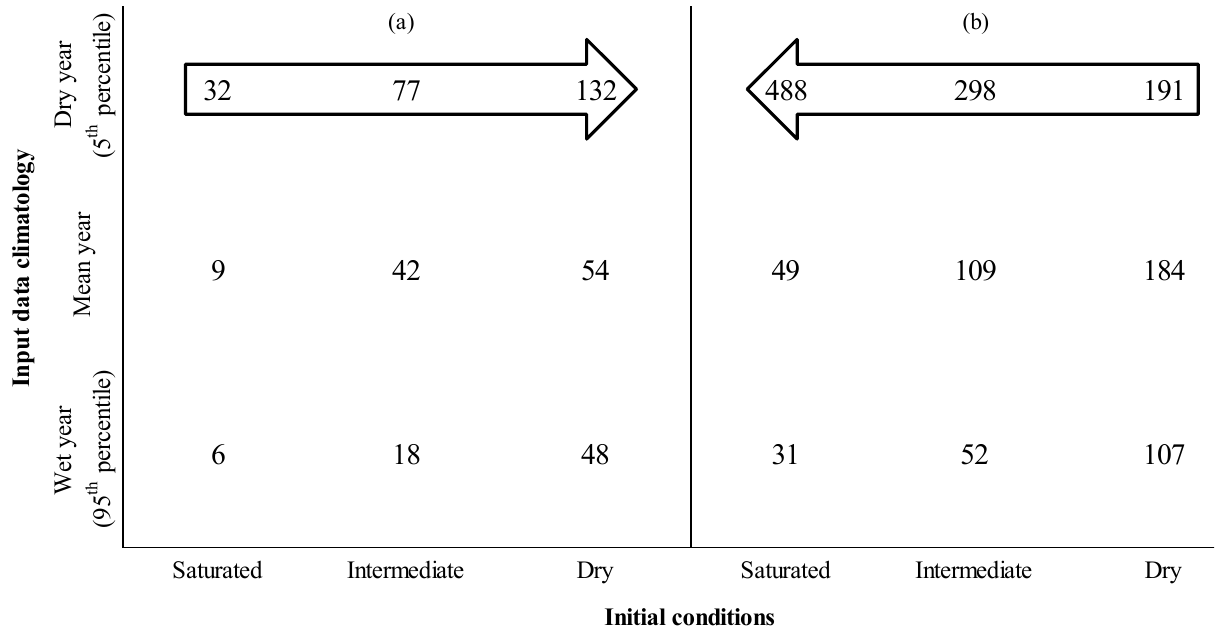
Figure 3. Average XAJ model spin-up time (in days) produced with different initial conditions and input data sets; ( a ) wet basins ( ζ < 0.9) ( b ) dry basins ( ζ >